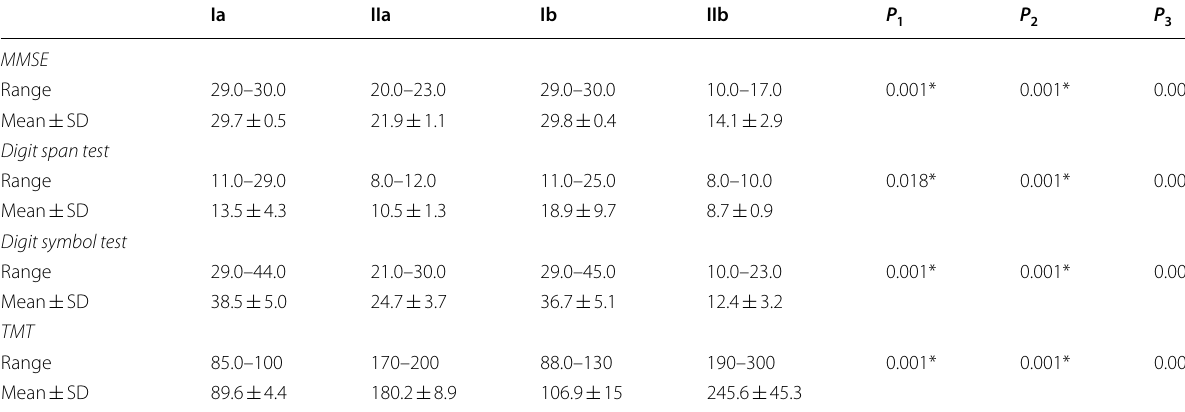
Table 1 Comparison of psychometric tests between different study subgroups